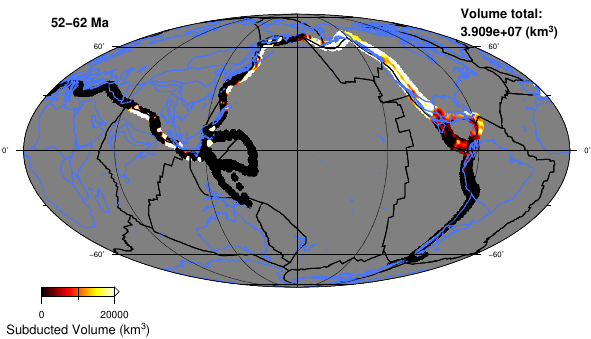
Figure B3. Integrated volume of subducted material between 62 and 52Ma. The colour scale represents the volume of material. The total amount of material for this time period is 3 . 9 × 10 7 km 3 .